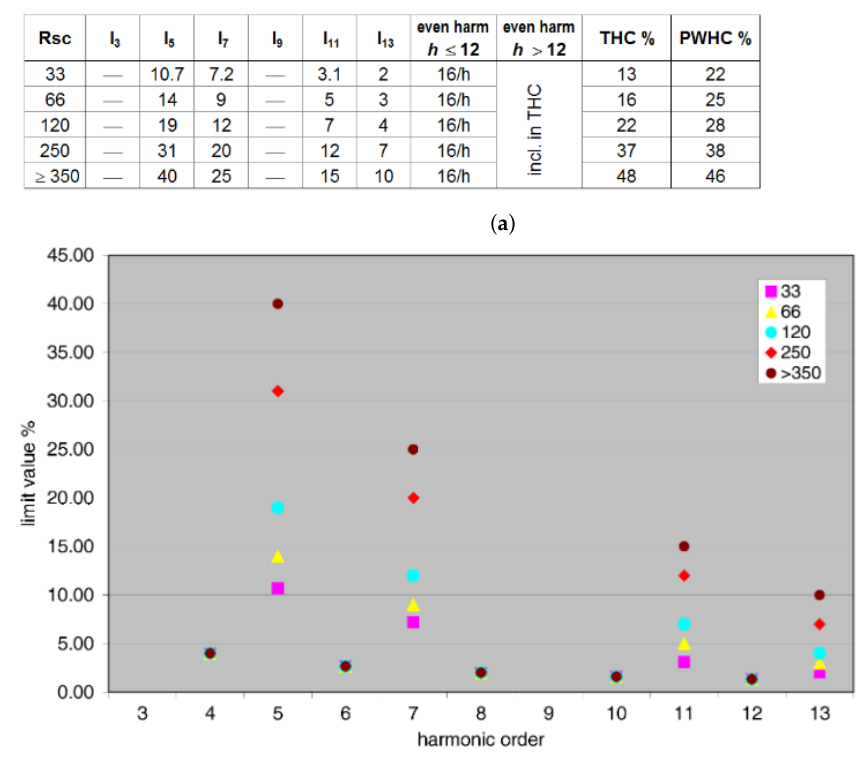
Figure 5. Harmonic distortion limits for balanced three-phase loads as a function of short-circuit ratio R sc (Table 3 of IEC 61000-3-12): ( a ) numeric values, ( b ) graphical